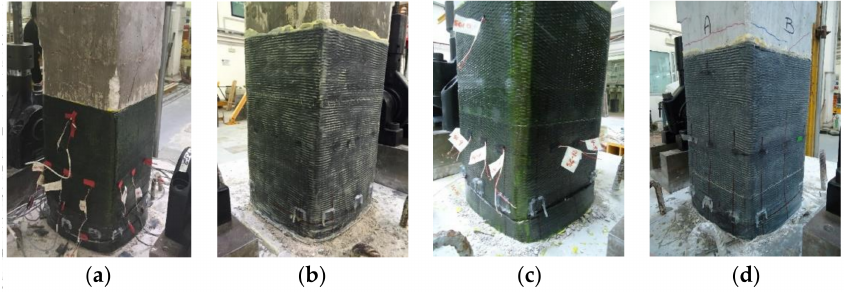
Figure 12. Damage at failure: ( a ) CL_FRPa; ( b ) CL_FRPb; ( c ) CM_FRPa; ( d )